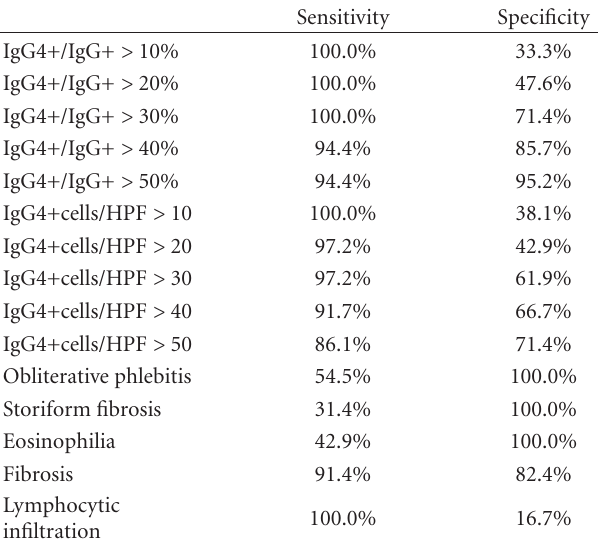
Table 4: Sensitivity and specificity of pathological findings for the diagnosis of IgG4-RD.